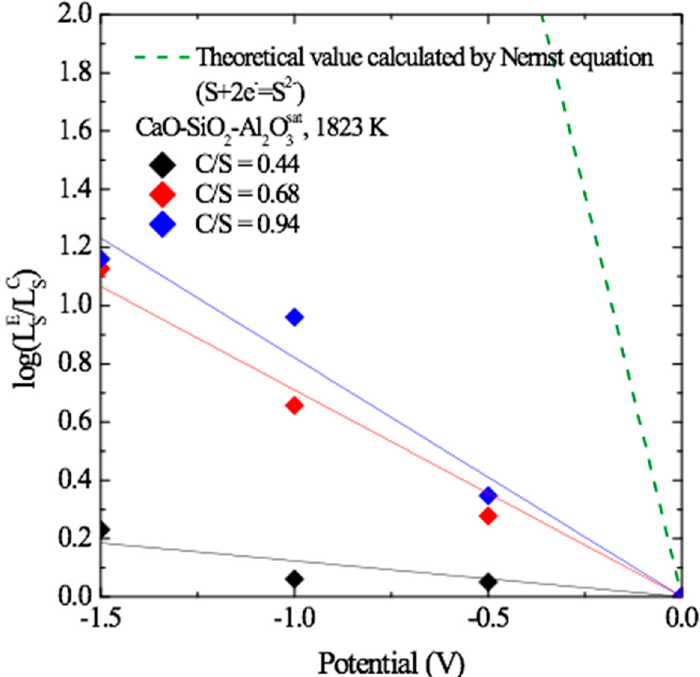
Figure 1. Sulfur partition ratio as a function of the cathodic potential in each of the three CaO-SiO 2 -Al 2 O 3 (CSA) melts at 1823 K.